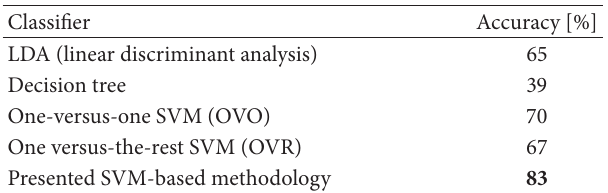
Figure 12: Range of motion of the quadriceps muscle from the reference model. Table 2: Overall classification